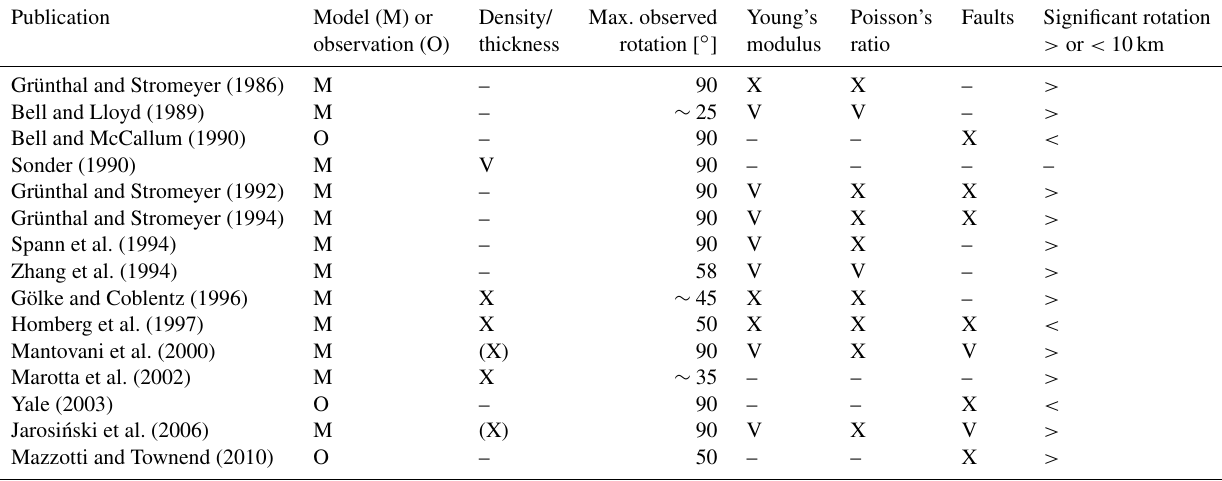
Table 1. Comparison of selected previous observations or models on the subject of stress rotation in the context of faults, elastic material properties, density or topography variation. The characters “X” and “V” indicate whether the property is included or varied; “(X)” means that the subject is included indirectly. The characters “ < ” and “ > ” indicate that significant rotation occurs near ( < 10km) or at greater distance ( > 10km) from the fault or material